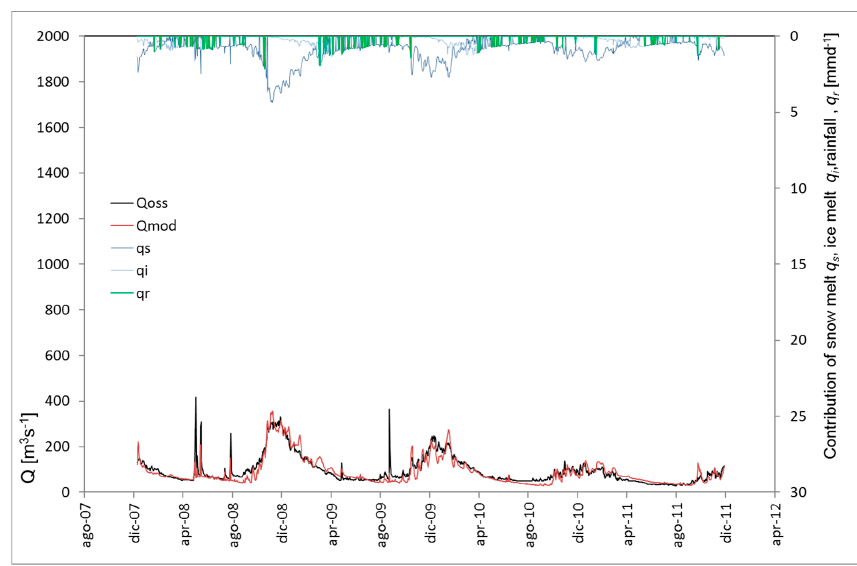
Figure 3. Rio Maipo at El Manzano. Model validation (2008–2011). Flow contribution (mm·day − 1 ), snow melt q s , ice melt q i , rainfall q r . Table 3. Poly-Hydro parameters in calibration (1994–2003), and goodness of fit (calibration/validation). Parameter in italics are from literature, or defined a priori. Method of estimation explained. Goodness of fit measures reported with method of estimation (e.g., minimization of Bias , maximization of NSE , etc.). We also report yearly and seasonal flow statistic, observed, and modelled. Seasonal flows reported with confidence limits (±95%) to assess goodness of fit.